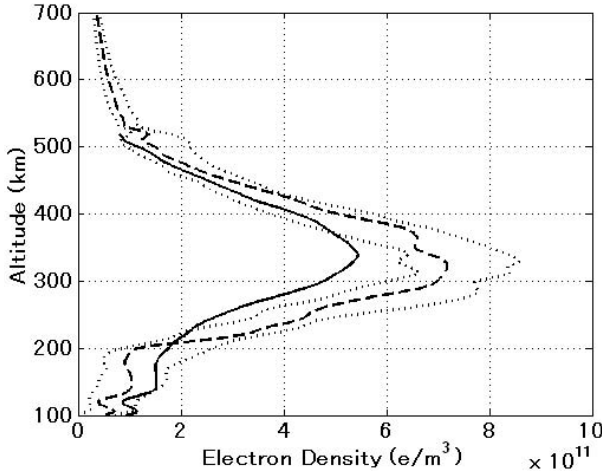
Fig. 15. Ionospheric electron density profiles obtained from FORMOSAT-3/C. The solid line indicates the profile observed on 9 September. The dashed and dotted lines indicate the median and first and third quartile values calculated during the period from 25 August to 8 September,